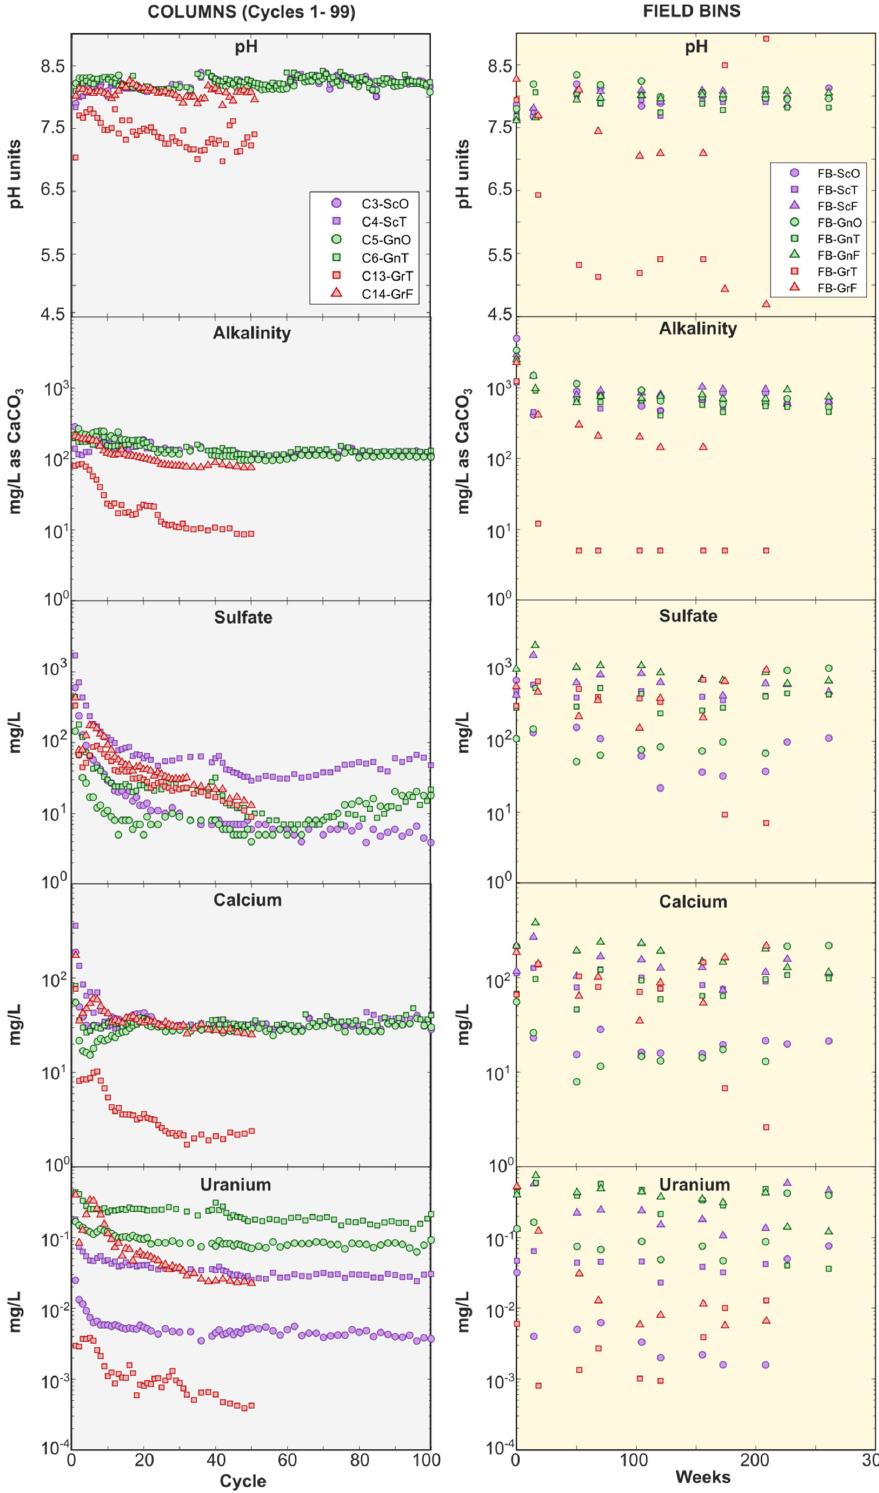
Figure 5. Column ( left panel ) and field bin ( right panel ) leachate pH, alkalinity, sulfate, Ca, and U. For column tests, only cycles representing Phase 1, i.e., prior to the sequencing experiments, are shown (i.e., cycles 1 to 99). Note differences in y-axis scale between left and right panels. Symbol shape indicates weathering facies: triangles = fresh; squares = transition; circles = oxide. Color indicates lithology: green = gneiss; red = granite; purple =